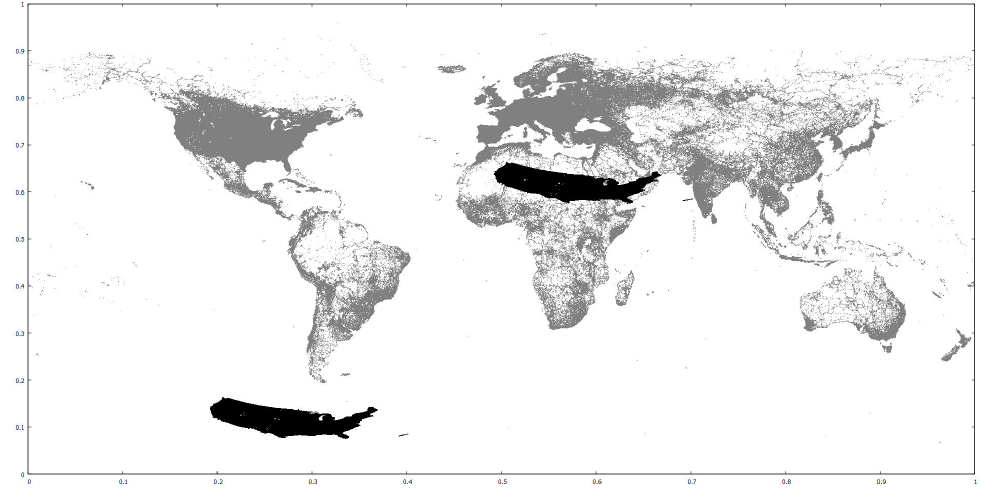
Figure 18. Road networks (gray), hydrography datasets in default (black, below South America) and new (black, over Sahara desert) location. Table 5.